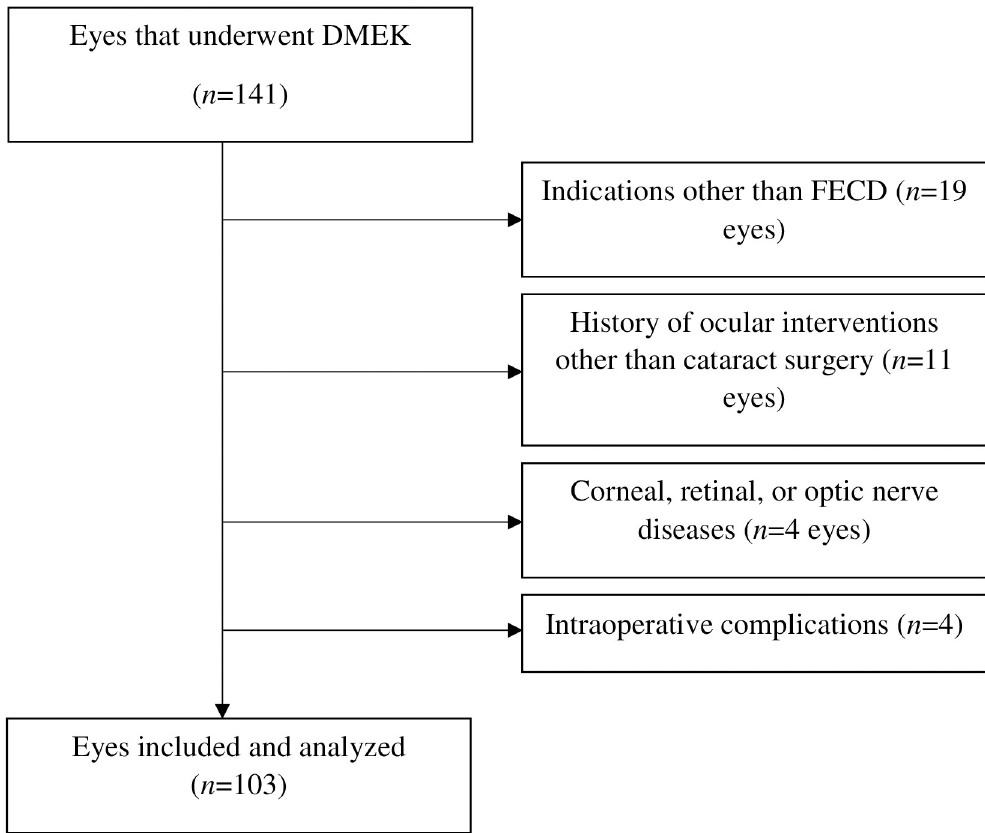
Fig 1. Flow chart showing patient disposition in the